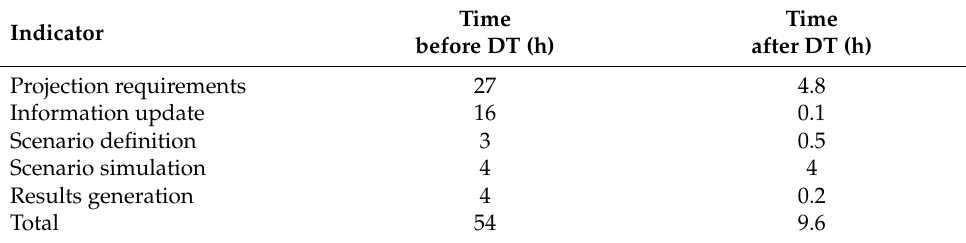
Table 1. Time comparison for price prediction